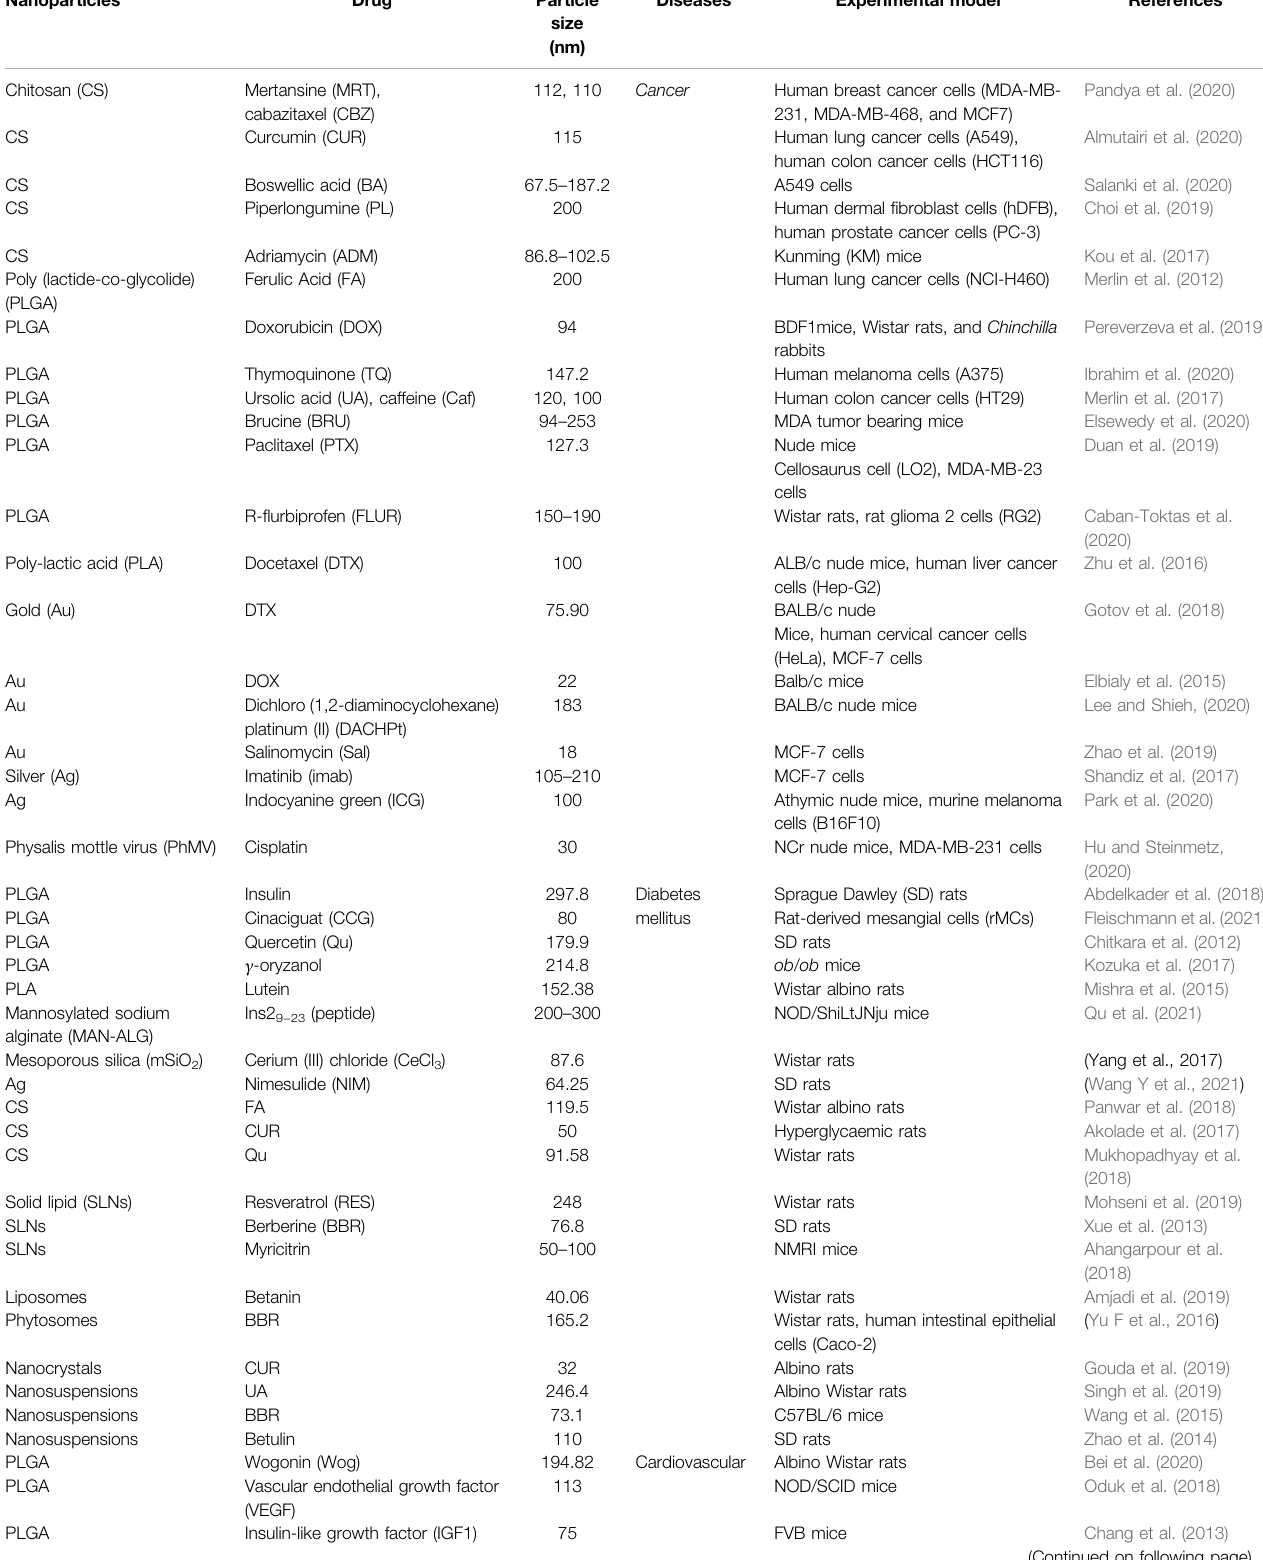
TABLE 2 | Elucidate drug delivery system of nanoparticles in treatment of various